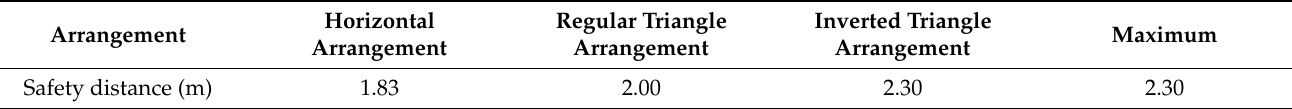
Table 3. Safety distance under different arrangement modes of 110 kV.